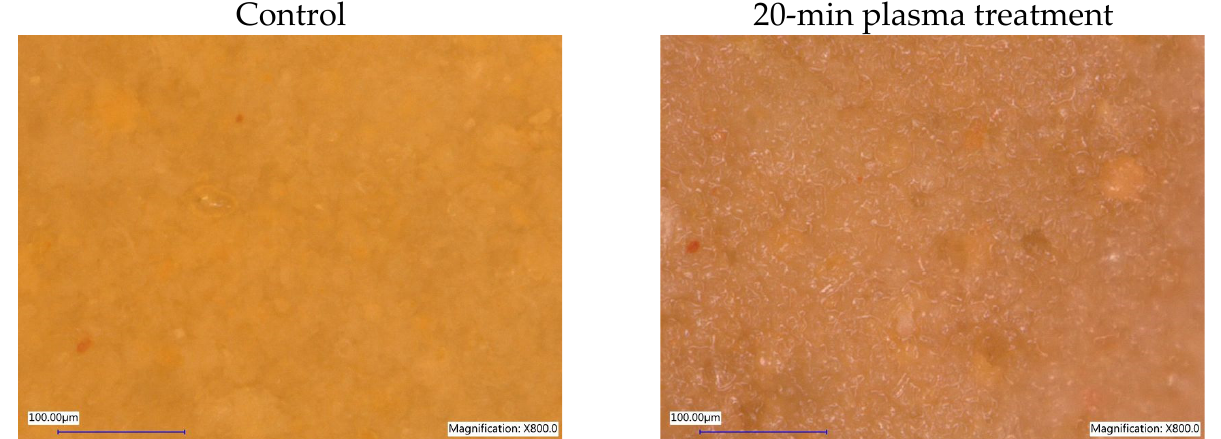
Figure 3. Microscopic imaging of diatomaceous earth before and after non-equilibrium plasma treat- ment—KEYENCE VHX-5000 optical microscope, magnification 800×.